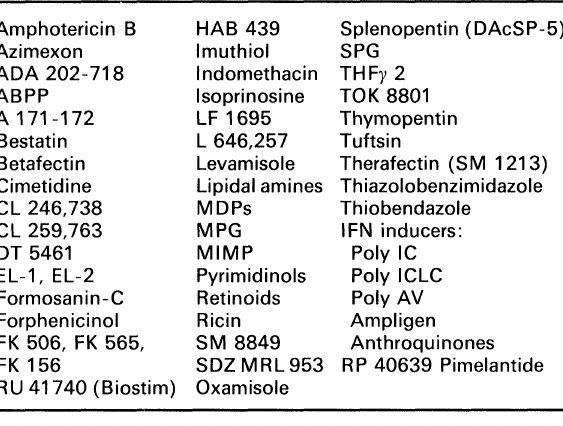
Table 5. Polysaccharide biological response modifiers